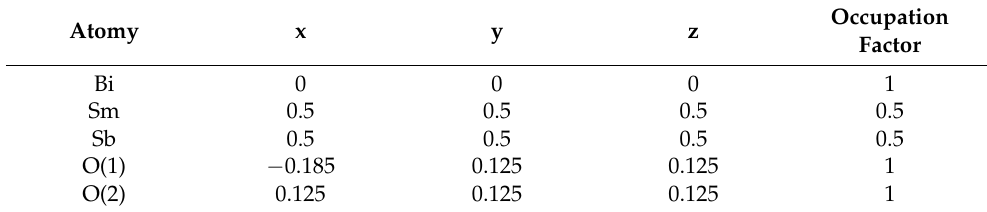
Figure 1. ( a ) XRD and corresponding Rietveld truing of Bi 2 SmSbO 7 (red dotted line represents experimentative XRD datum of Bi 2 SmSbO 7 ; blue solid line represents simulative XRD data of Bi 2 SmSbO 7 ; black solid line is the disparity between experimentative XRD datum of Bi 2 SmSbO 7 and analogous XRD datum of Bi 2 SmSbO 7 ; green perpendicular is the observed reflective locality); ( b ) Atomy construction of Bi 2 SmSbO 7 . (Rubious atomy: O, dark purple atomy: Bi, light purpure atomy: Sm or Sb.). Table 1. Crystallinenature parameters of Bi 2 SmSbO 7